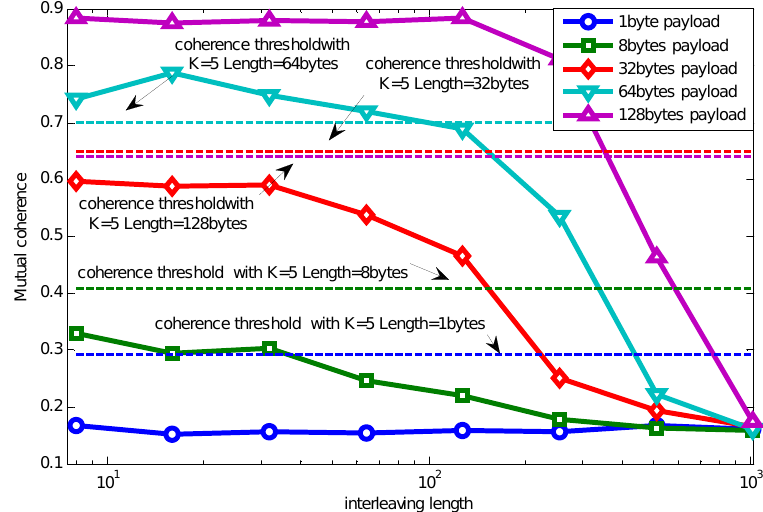
Figure 13. Relationship between mutual coherence and interleaving